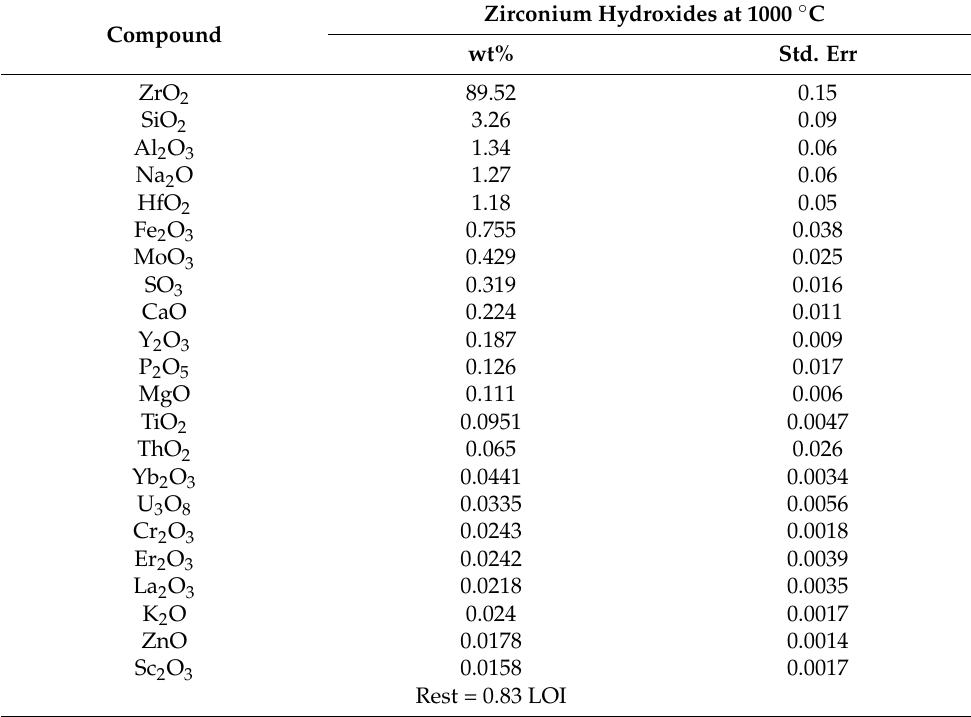
Table 1. Semiquantitative result of XRF identification on the chemical composition of local zircon- based zirconium hydroxide calcined at 1000 ◦